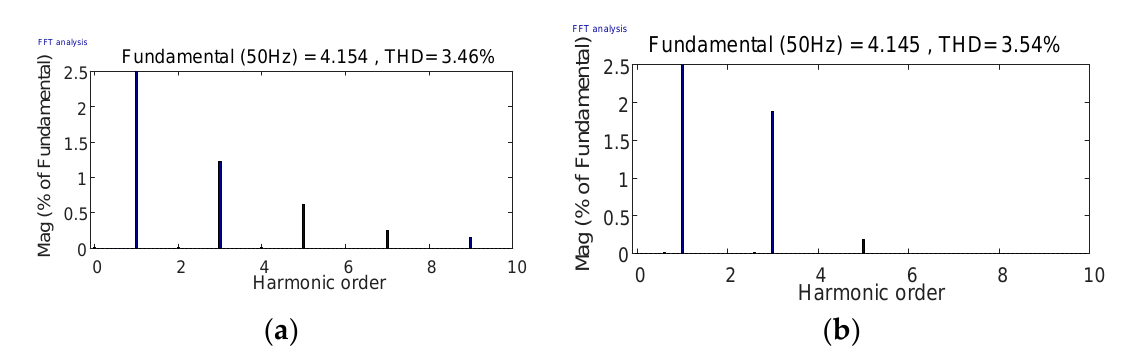
Figure 7. FFT spectrum of the AC output current with the CMS ( a ) and RVCMS ( b ) .